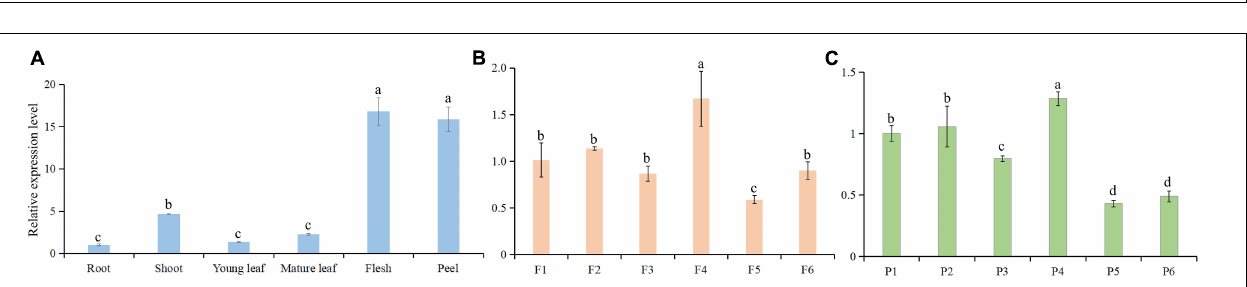
FIGURE 5 | Phylogenetic analysis of 43 FcWD40 proteins and TTG1s of other species. (A) Phylogenetic relationships of TTG1 proteins. GenBank accession numbers: Arabidopsis thaliana AtTTG1 (NM_122360), Malus domestica MdTTG1 (GU173813), Pyrus pyrifolia PyWD40 (HQ641374.1), Fragaria × ananassa FaTTG1 (JQ989287), Camellia sinensis CsWD40 (MH618664), Punica granatum PgTTG1 (HQ199314), G ossypium hirsutum GhTTG3 (AAM95645), and Medicago truncatula , MtWD40 -1 (EU040206.1). FcWD40-97 is indicated with red dot. (B) Alignment of deduced amino acid sequences of FcWD40 proteins and other known TTG1 homologs. The four conserved amino acid residue pairs (WD, FD, LD, and WE) are marked by different-colored straight lines.